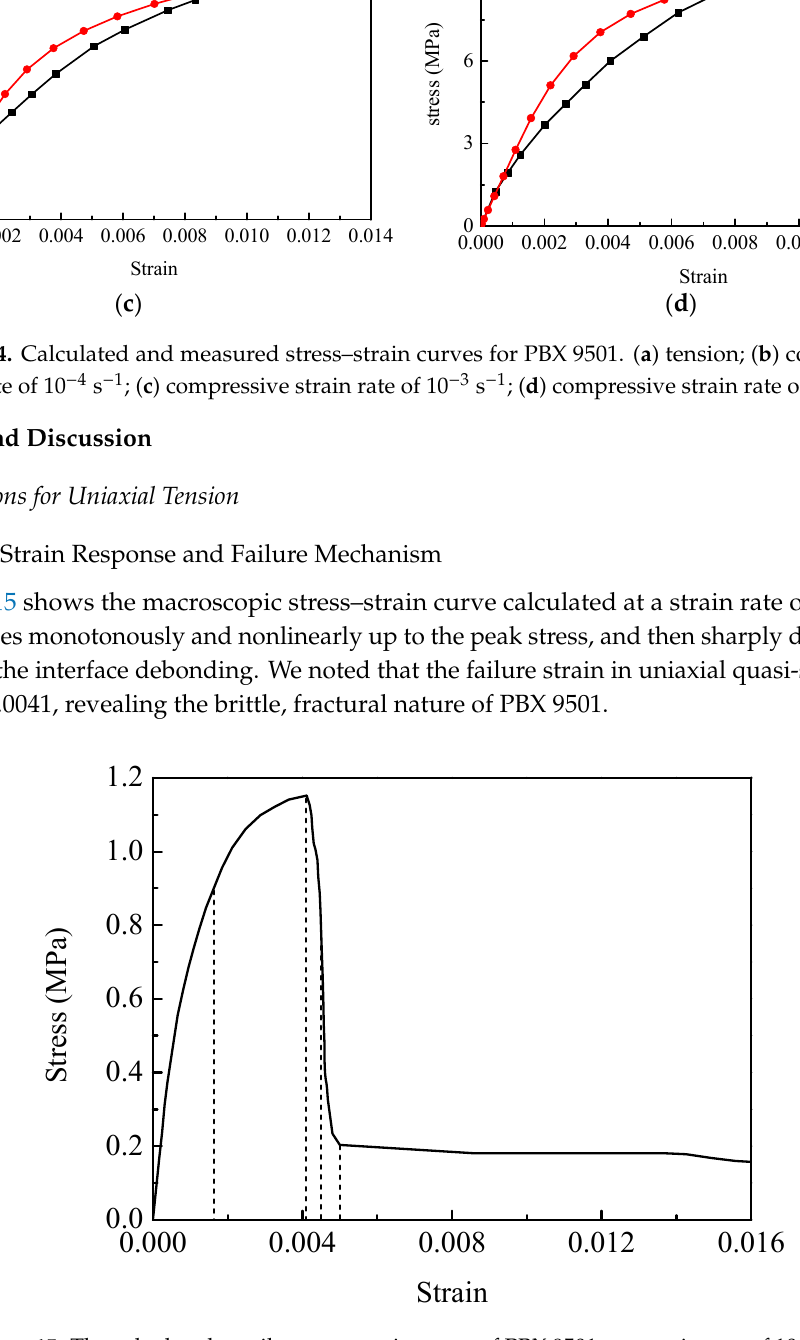
Figure 15. The calculated tensile stress–strain curve of PBX 9501 at a strain rate of 10 − 3 s − 1 . The true strain contours of y-direction ε y and the failure evolution at the macroscopic strains of 0.16%, 0.41%, 0.45%, and 0.5% (marked by dash line in Figure 15) are shown in Figure 16. The soft